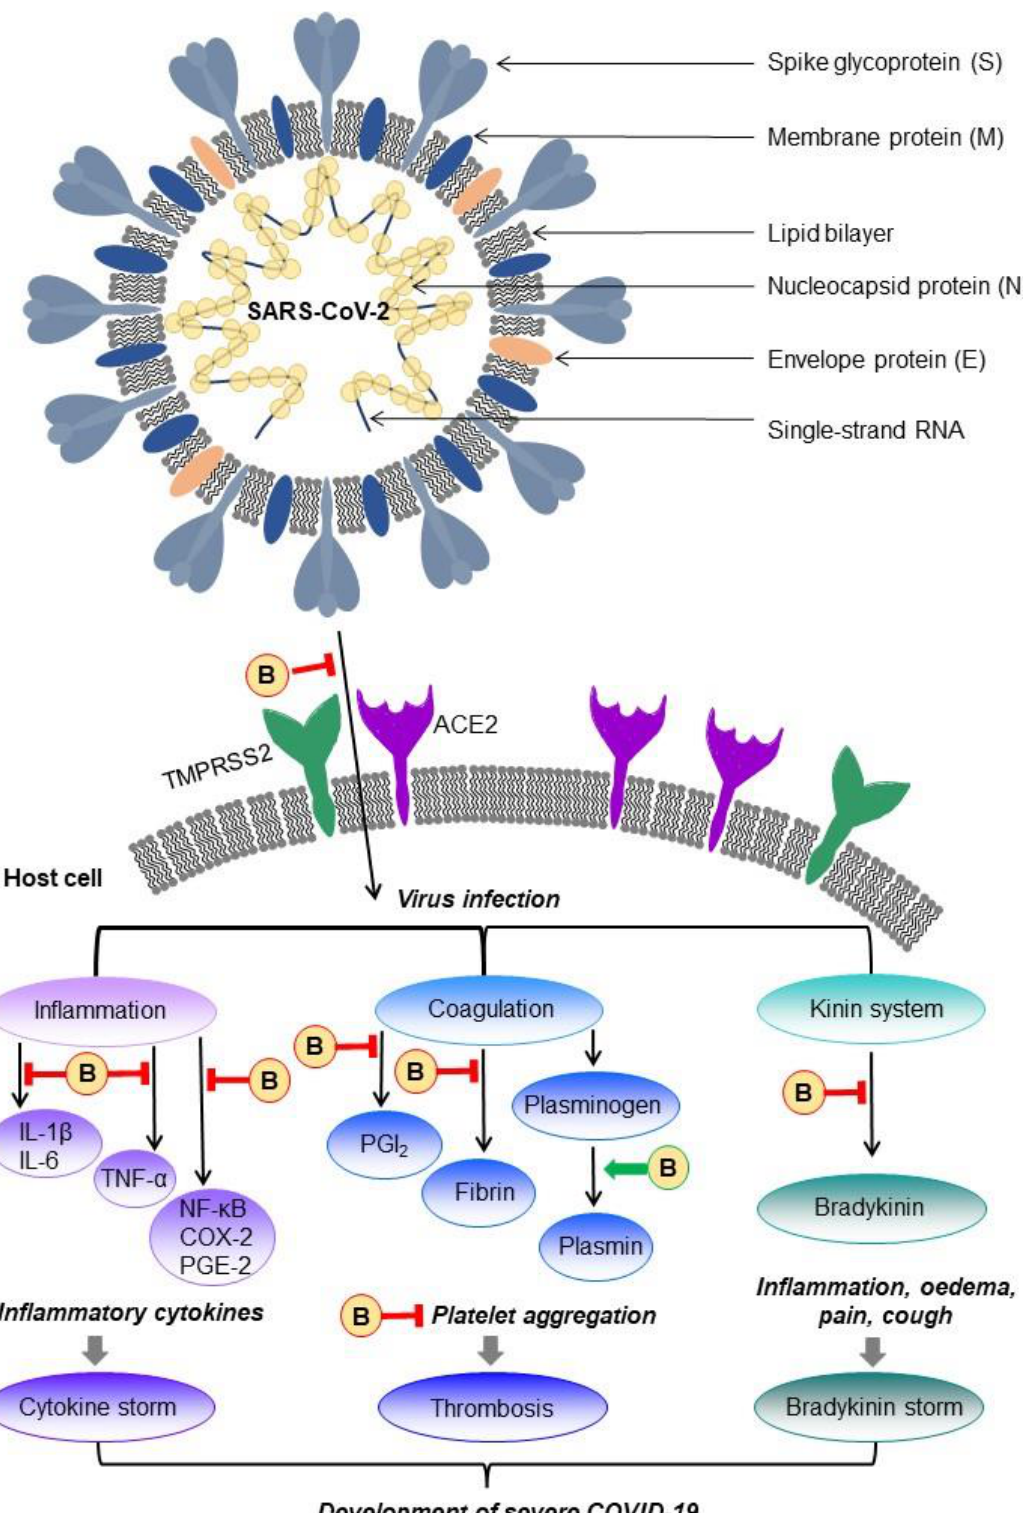
Figure 2. The structure of the SARS-CoV-2 virus and the interference of multiple activity of bromelain (B) in the crucial steps of COVID-19 pathophysiology. TMPRSS2, transmembrane serine protease 2; ACE2, angiotensin-converting enzyme II receptor; IL-1 β , interleukin 1 beta; IL-6, interleukin 6; TNF- α , tumor necrosis factor-alpha; NF- κ B, nuclear factor kappa- light-chain-enhancer of activated B cells; COX-2, cyclooxygenase 2; PGE-2, prostaglandin E-2; PGI2,